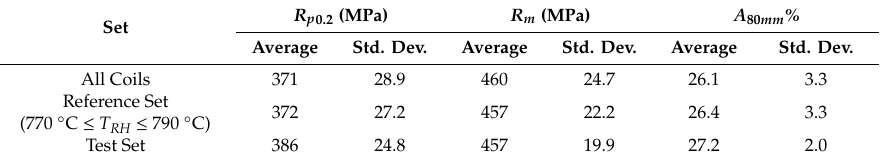
Table 7. Results of the o ffl ine tests for Steel Code C and thickness range 2 (0.7–0.9 mm).